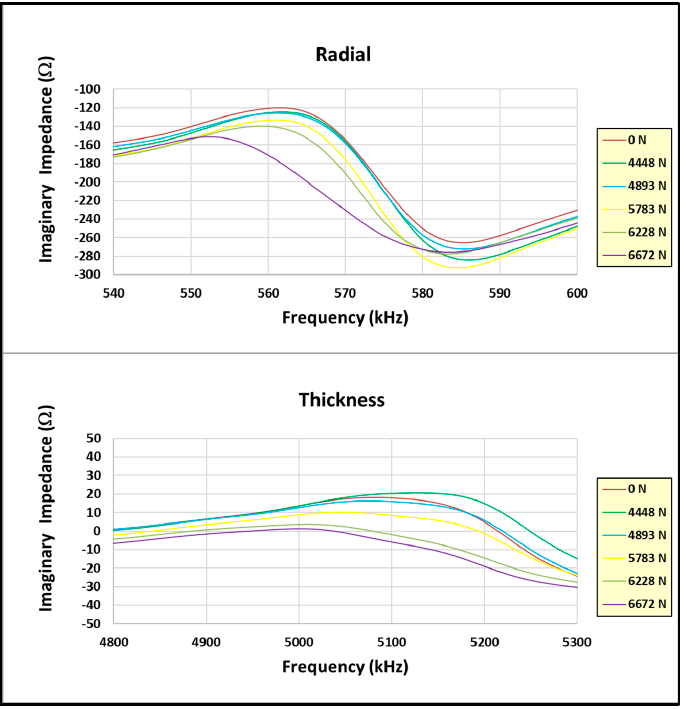
Figure 25. Radial and thickness impedance (imaginary) resonance and load level for Sensor 11.